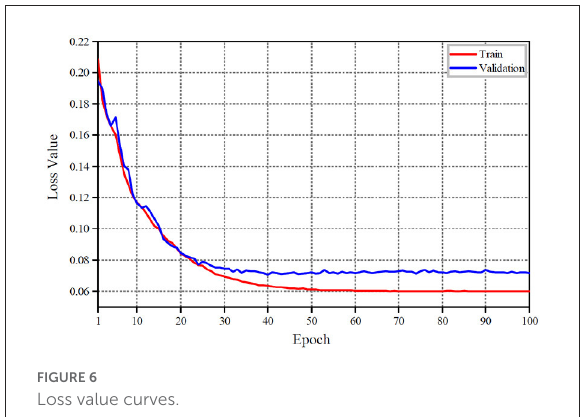
FIGURE6 Loss value curves.